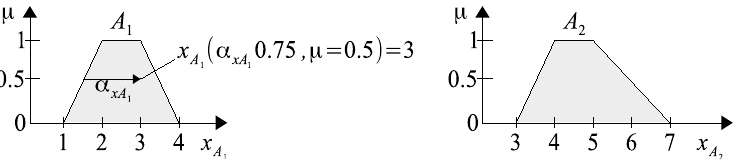
Figure 3. Illustration of the sense of the horizontal MF as a function that models not only the borders but also the interior: the body of MF. The variable α xA inside these